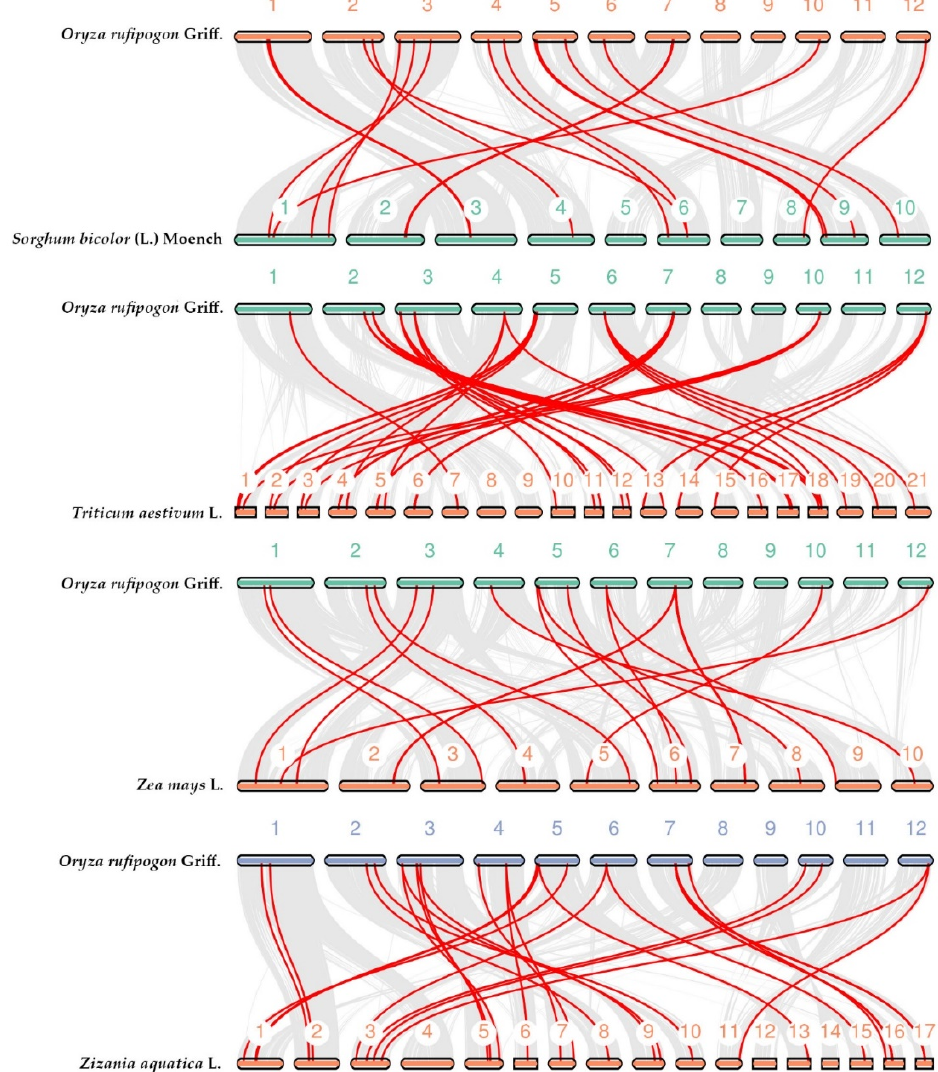
Figure 3. The collinearity analysis of the DXWR and gramineaes plants. Arabic numerals indicate chromosome numbers. The red line highlights the collinearity gene pairs containing the DUF26 domain-containing genes among different